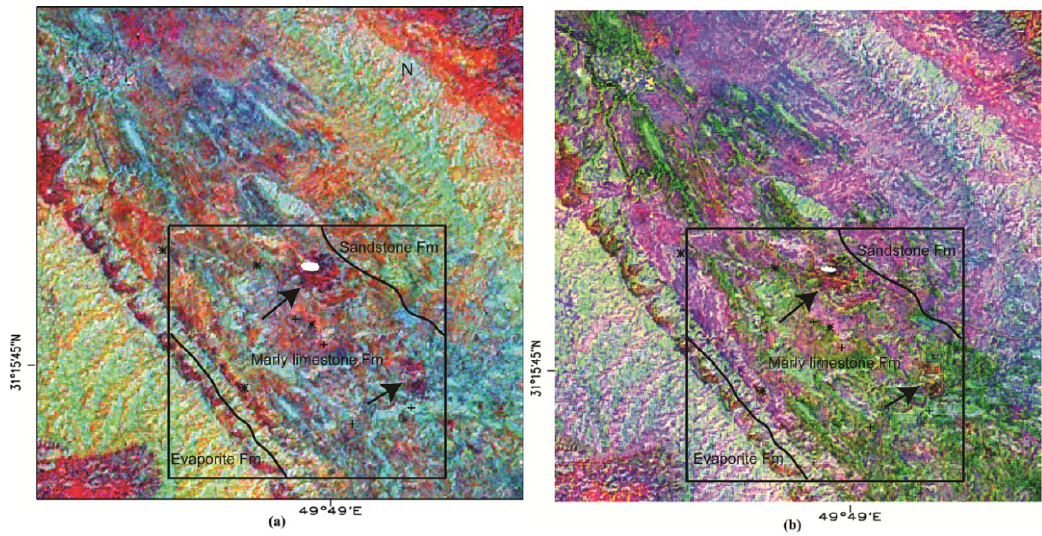
Figure 5. ( a ) A false colour composite created from relative absorption-band depth (RBD) and band ratios: b4/(b6 + b9) in red for enhancing gypsum, (b7 + b9)/b8 in green for enhancing calcite and (b5 + b7)/b6 in blue for enhancing clays; ( b ) false colour composite created from b4/(b6 + b9) for enhancing gypsum (red), b4/b3 for enhancing ferric iron (green) and b3/b1 for enhancing ferrous iron (blue). The black arrows point to the alteration zone in the Mishan marly limestone formation. The black box shows the extension of the region of interest (ROI) selected for ASTER classification and WV-2 image processing, and the arrows point to alterations induced by gas in the marly limestone formation. The white circles show field observations. The asterisks and plus symbols show the gas seep indications in the geological map of the study area.